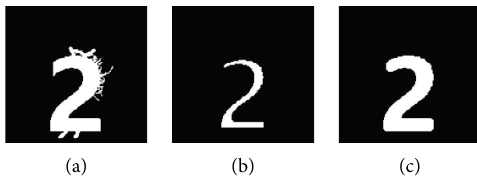
Figure 4: Demonstration of erosion and dilation: (a) original, (b) erosion, and (c) dilation.